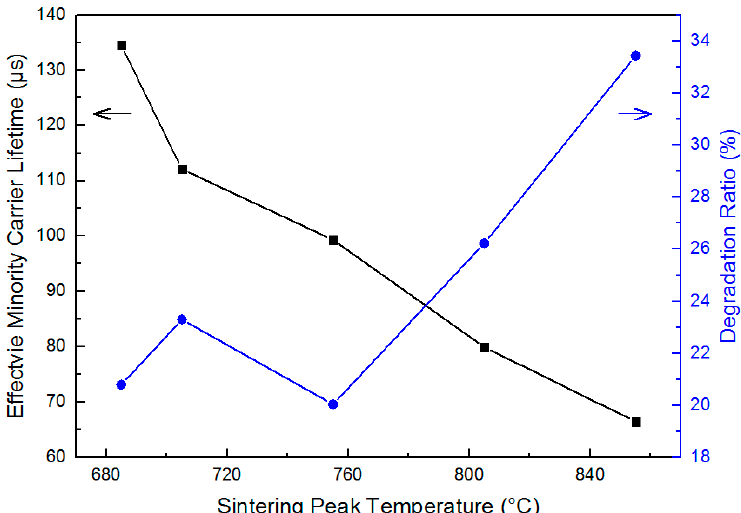
Figure 3. Initial effective minority carrier lifetimes (black squares) at ∆ n = 1 × 10 15 cm − 3 after sintering with different peak temperatures of boron-doped mc-Si lifetime samples with symmetrical passivation structure. The corresponding degradation ratios after 5 h of illumination are shown as blue circles.